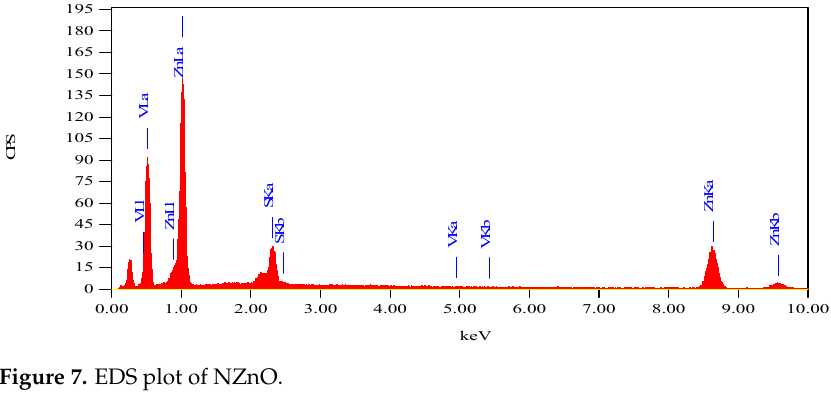
Figure 7. EDS plot of